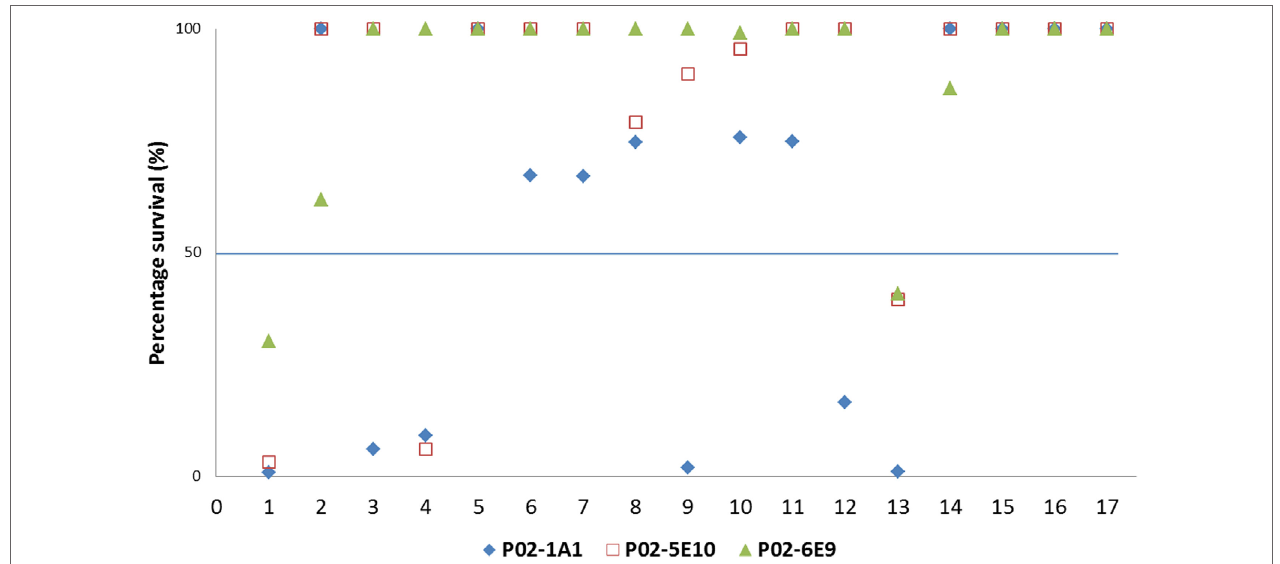
FigUre 6 | SBA of P02-1A1, P02-5E10, and P02-6E9 versus MenB strains. Numbers represent strains as follows: 1. M14-240312; 2. MC58; 3. M07-0240646; 4. M07-0240657; 5. M07-0240669; 6. M07-0240679; 7. M07-0240680; 8. M07-0240909; 9. M08-0240014; 10. M08-0240107; 11. M08-0240164; 12. M08- 0240276; 13. M10-240474; 14. M10-240476; 15. M10-240480; 16. M11-240016; 17. M11-240123. Assays were performed with hmAbs normalized to a final assay concentration of 80 µg/ml, in three biological replicates.